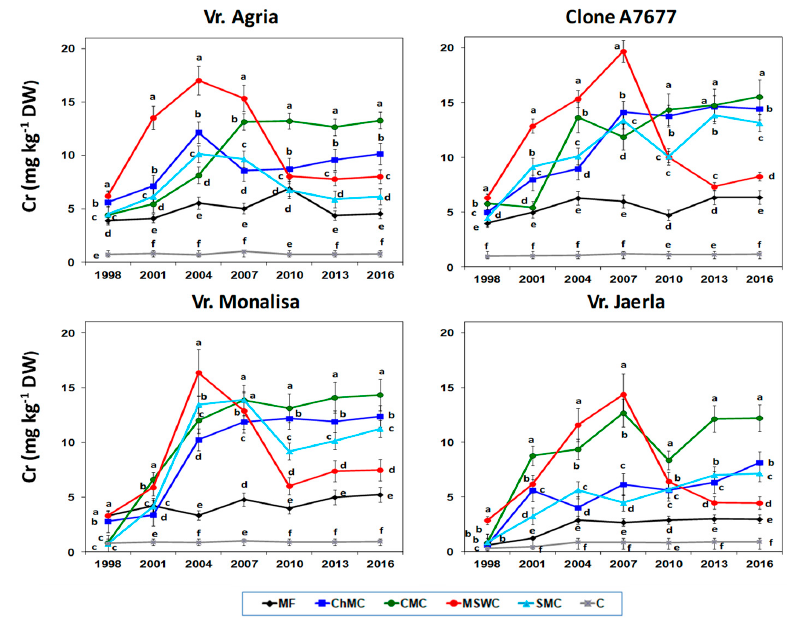
Figure 12. Evolution of chromium content (mg kg − 1 DW) in potato tubers of the Agria, Monalisa, Jaerla and clone A7677 varieties (1998–2016) versus the application of compost from different organic amendments. The means with different lowercase letters within each season indicate significant differences between the treatments ( p < 0.001). Bars stands for standard deviations. MF: mineral fertilizer; ChMC: chicken manure compost; CMC: cow manure compost; MSWC: municipal solid waste compost; SMC: sheep manure compost; C: control. Agronomy 2020 , 10 , x FOR PEER REVIEW